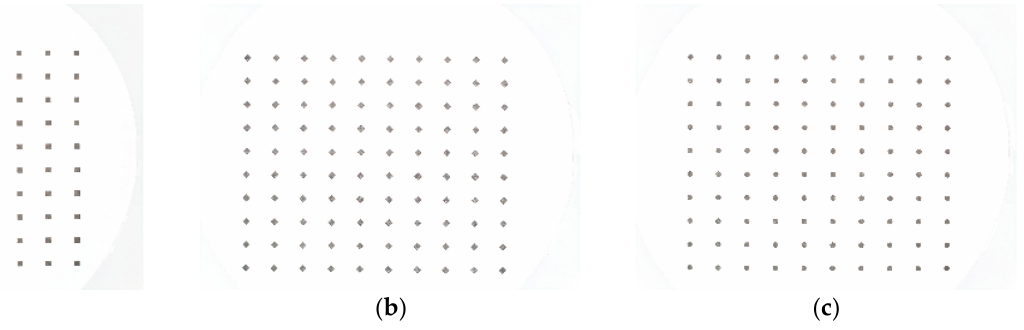
Figure 4. Some examples of test images used for the characterization of the vision system. Each image is a 10 × 10 matrix of ( a ) unrotated 2.00 mm squares, ( b ) 45° rotated 2.0 mm squares and ( c ) 2.0 mm circles.